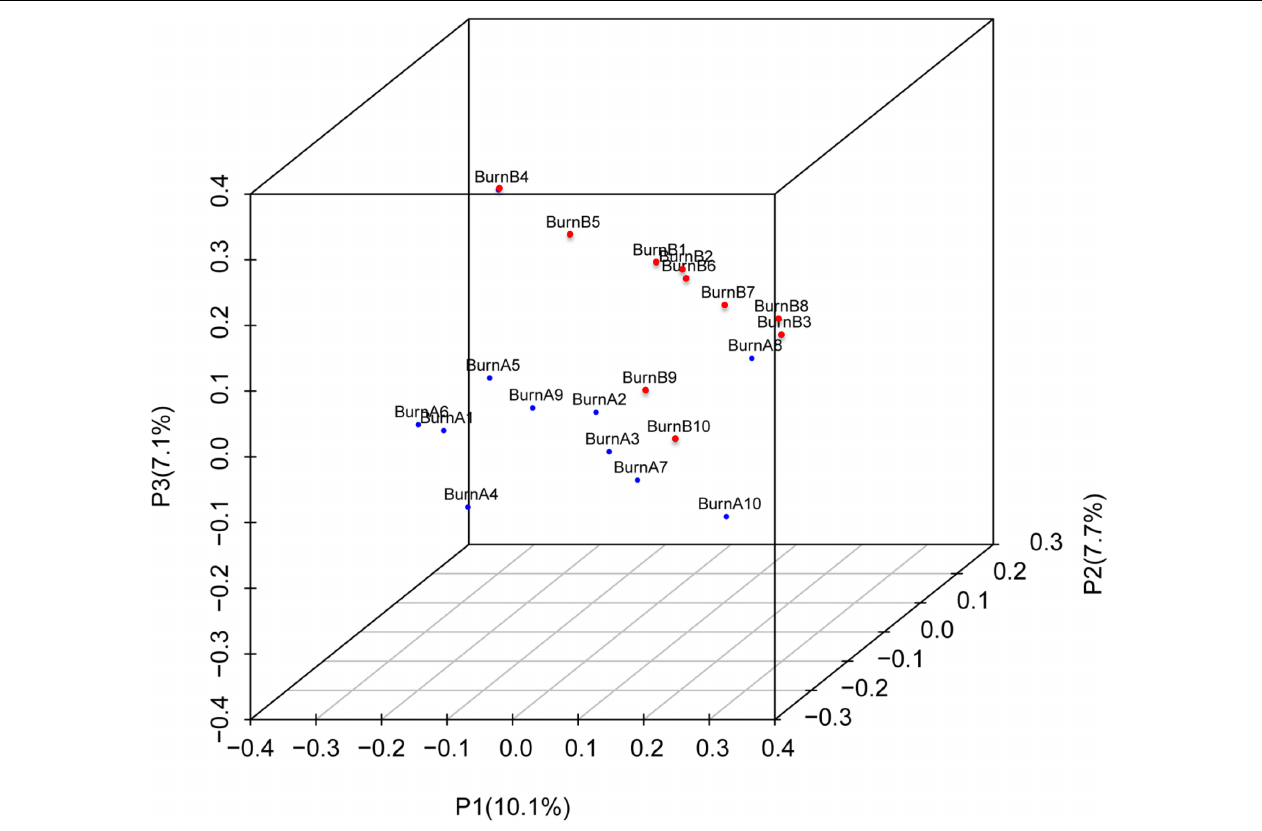
FIGURE 4 | Principal component analysis (PCA) 3D plot of the operational taxonomic unit. Pre-burn samples are shown in blue and the post-burn samples are shown in red. PCA axis 1 accounts for 29.8% of the inter-sample variation, PCA axis 2 accounts for 18.7% of the inter-sample variation, and PCA axis 3 accounts for 13.2% of the inter-sample